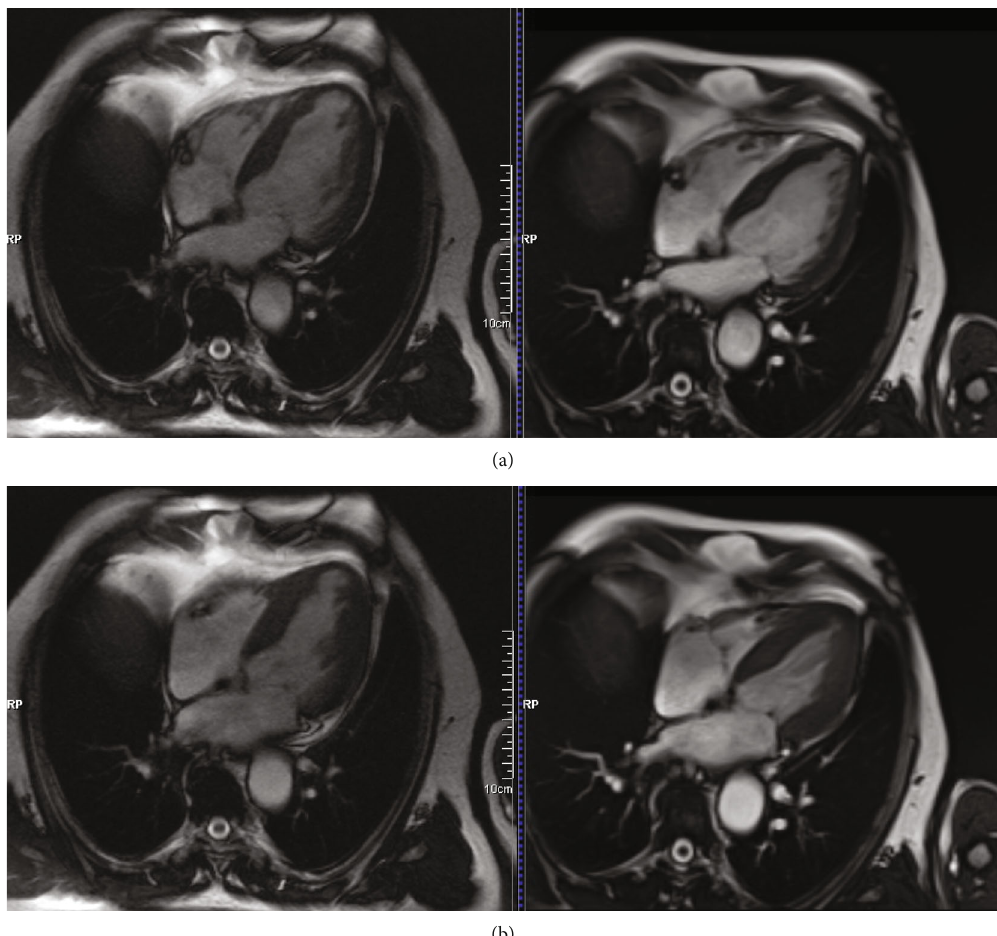
Figure 2: Cardiac magnetic resonance assessment at baseline and at 12 months follow-up. 71 years old male, cine SSFP (steady-state free precession) 4 chamber view — diastolic (a) and systolic (b) phase. LVEF 43% vs 54% at 12 months